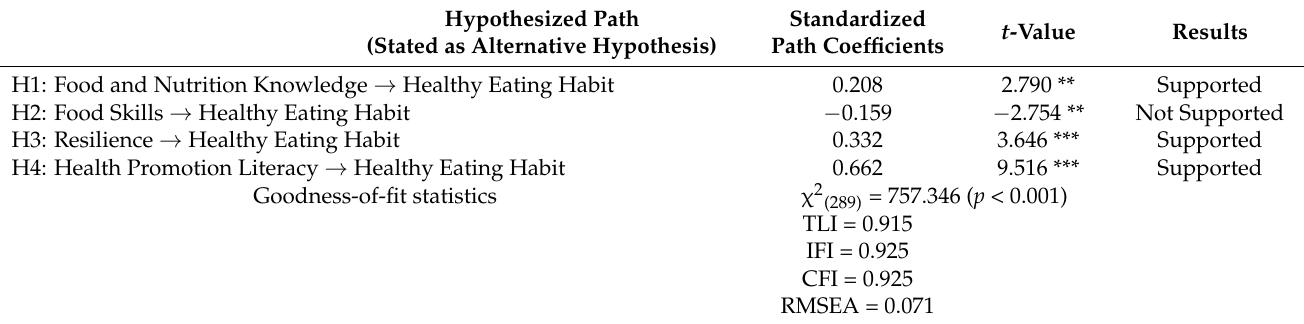
Table 3. Structural parameter